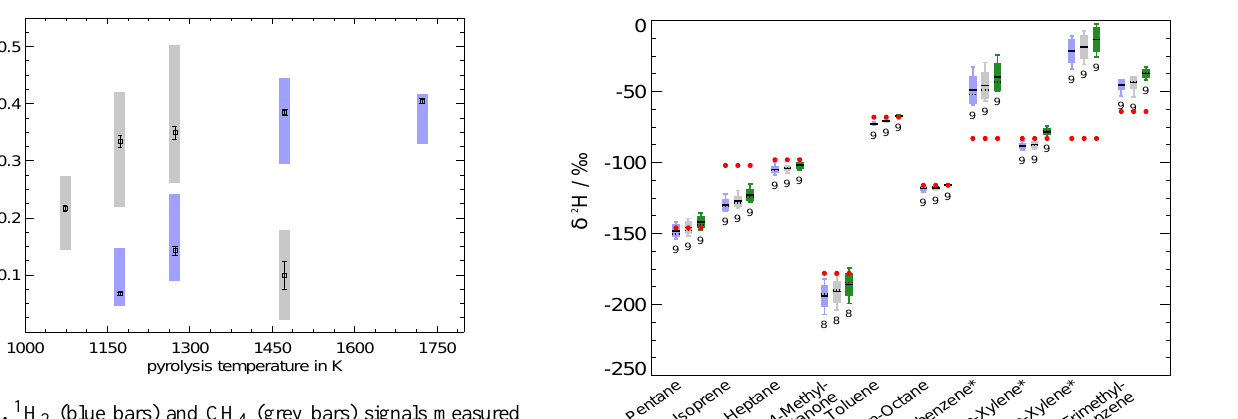
Figure 7. 1 H 2 (blue bars) and CH 4 (grey bars) signals measured with the IRMS are shown in relative units (see text for more de- tail) for different pyrolysis temperatures. The bars represent results for all measured compounds including standard deviations. As an example results of n -octane are shown by black squares including standard deviation (error bars).